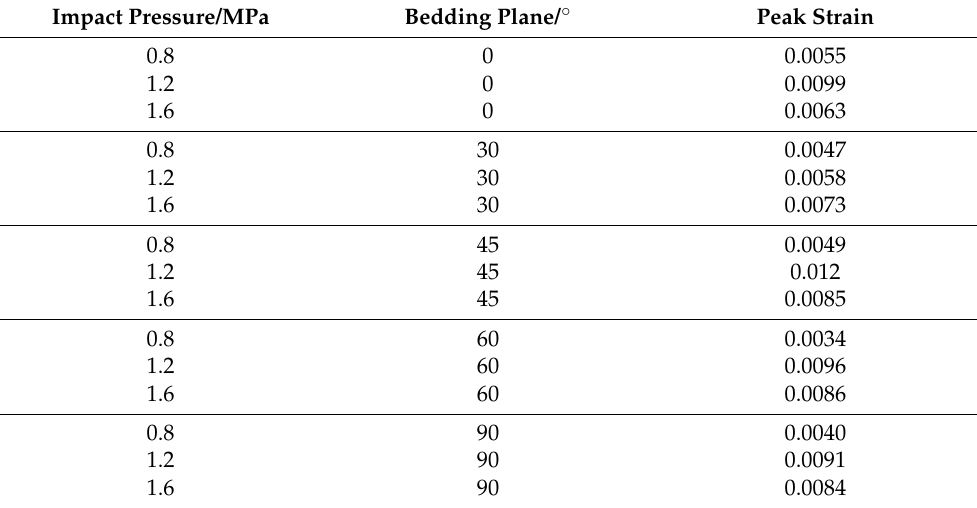
Table 2. Peak strain characteristics of sandstone.